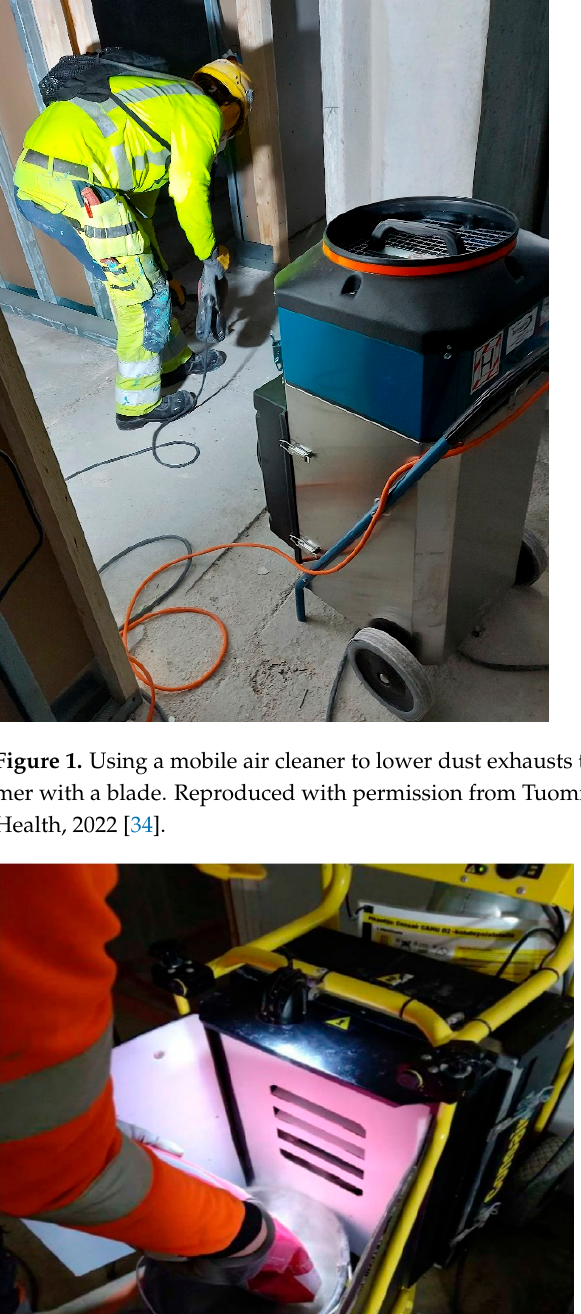
Figure 2. Use of a directed air cleaner in the mixing of mortar. Reproduced with permission from Tuomi et al., Finnish Institute of Occupational Health, 2022